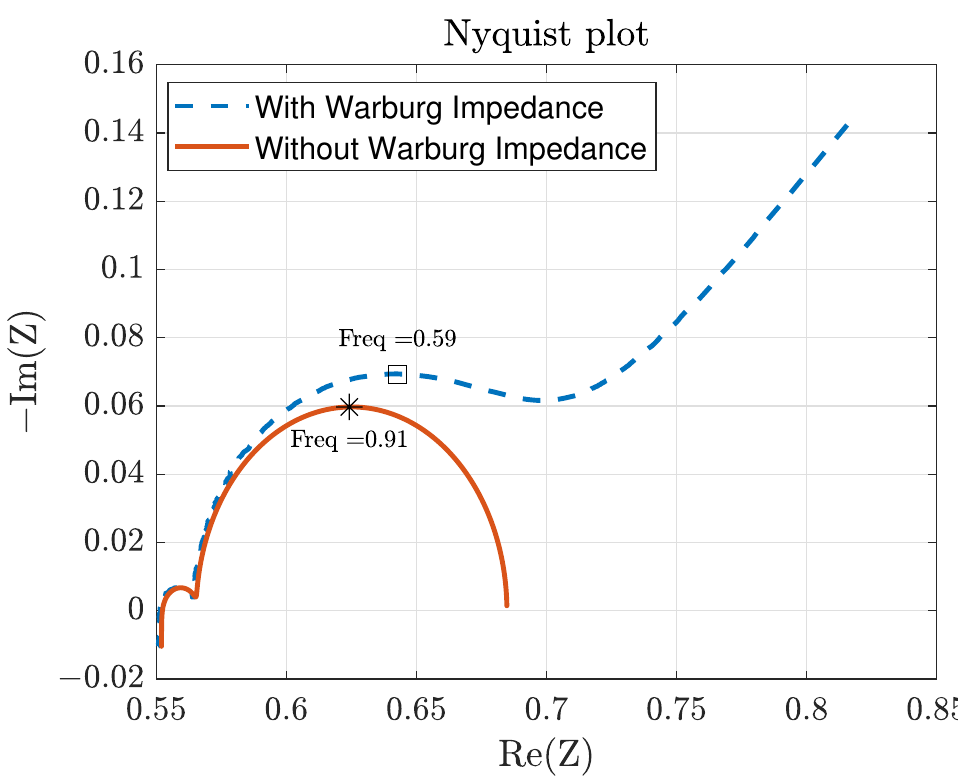
Figure 2. Effect of approximation on performance. The red line shows the Nyquist plot in the absence of Warburg impedance and the dashed line shows it when the Warburg impedance is present. The presence of Warburg impedance affected the frequency at the peak; this will affect the estimated value of R CT and C DL (see